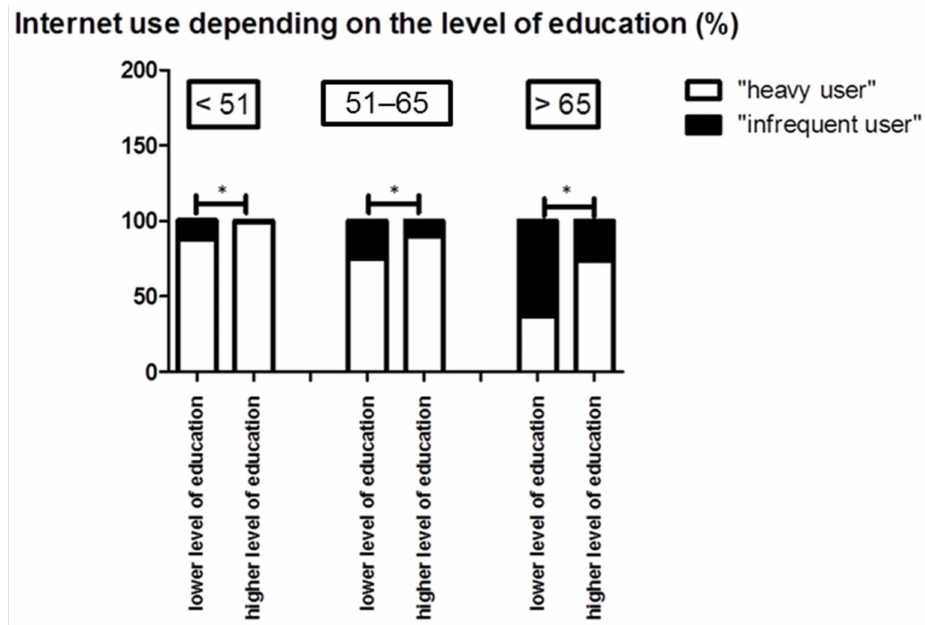
Figure 3. Internet use depending on the level of education. Younger patients and patients with a higher level of education more frequently used the Internet ( p = 0.05). Abbreviations: * p <